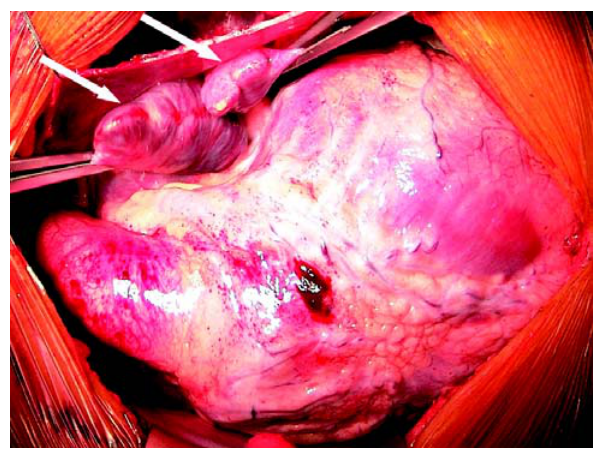
Fig. 2 – Justaposição dos apêndices atriais à esquerda